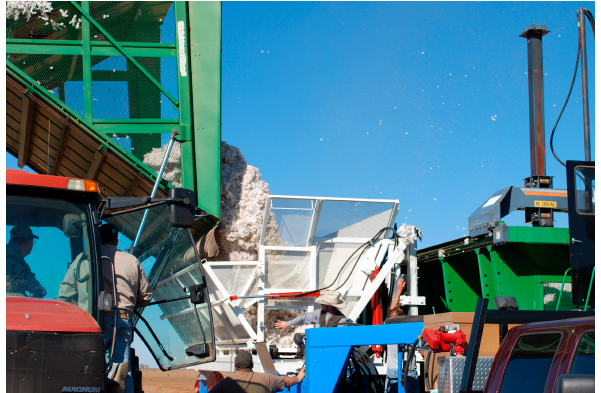
Figure 4. Harvester unloaded freshly harvested seedcotton into the instrumented Figure 4. weigh-cart/micro-module builder used to create the 110 kg micro-modules. weigh-cart/micro-module builder used to create the 110 kg